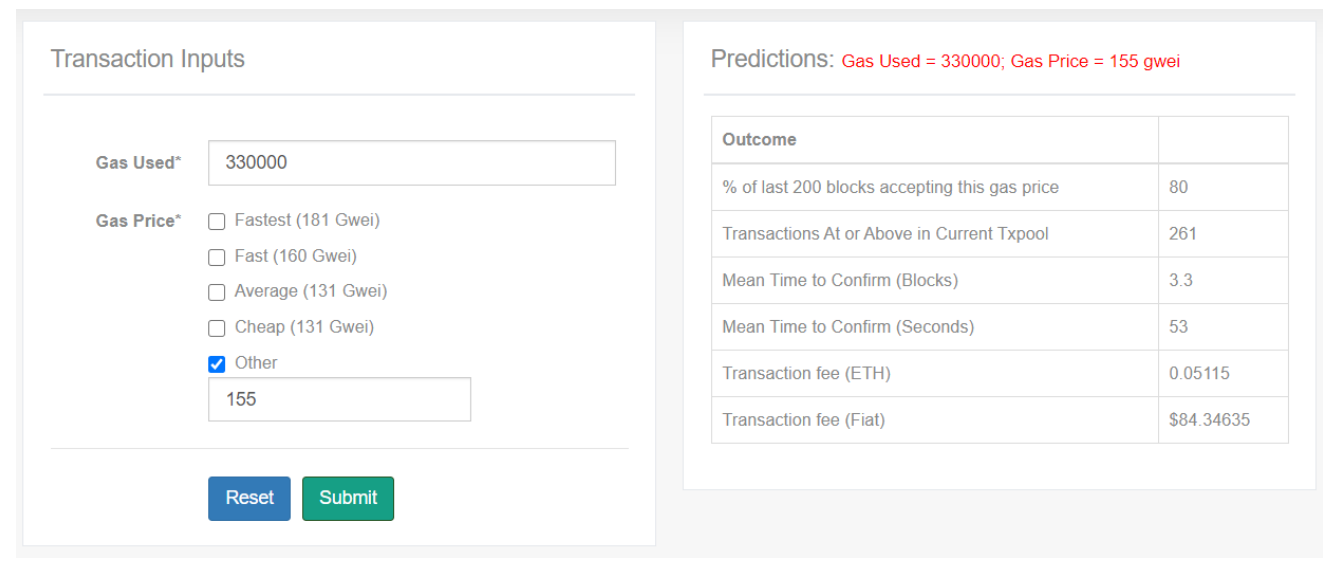
Figure 22. The gas calculator.